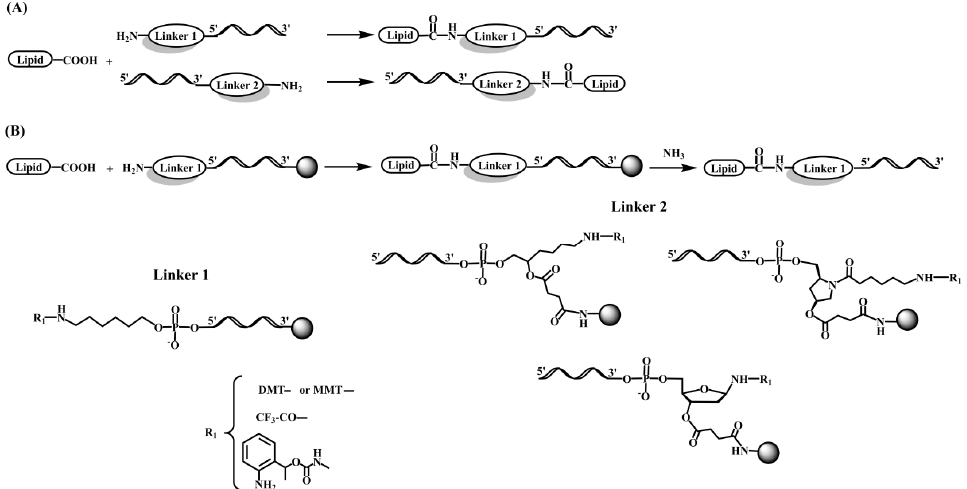
Figure 2. Chemical structure of several linker molecules connecting solid supports and lipids used for the preparation of lipid-oligonucleotide conjugates. ( A ) Lipid conjugation to the 5′ or 3′ end of an oligonucleotide in solution [35–37]. ( B ) Lipid conjugation to the 5′ or 3′ terminus of an oligonucleotide on a solid support [29,31].